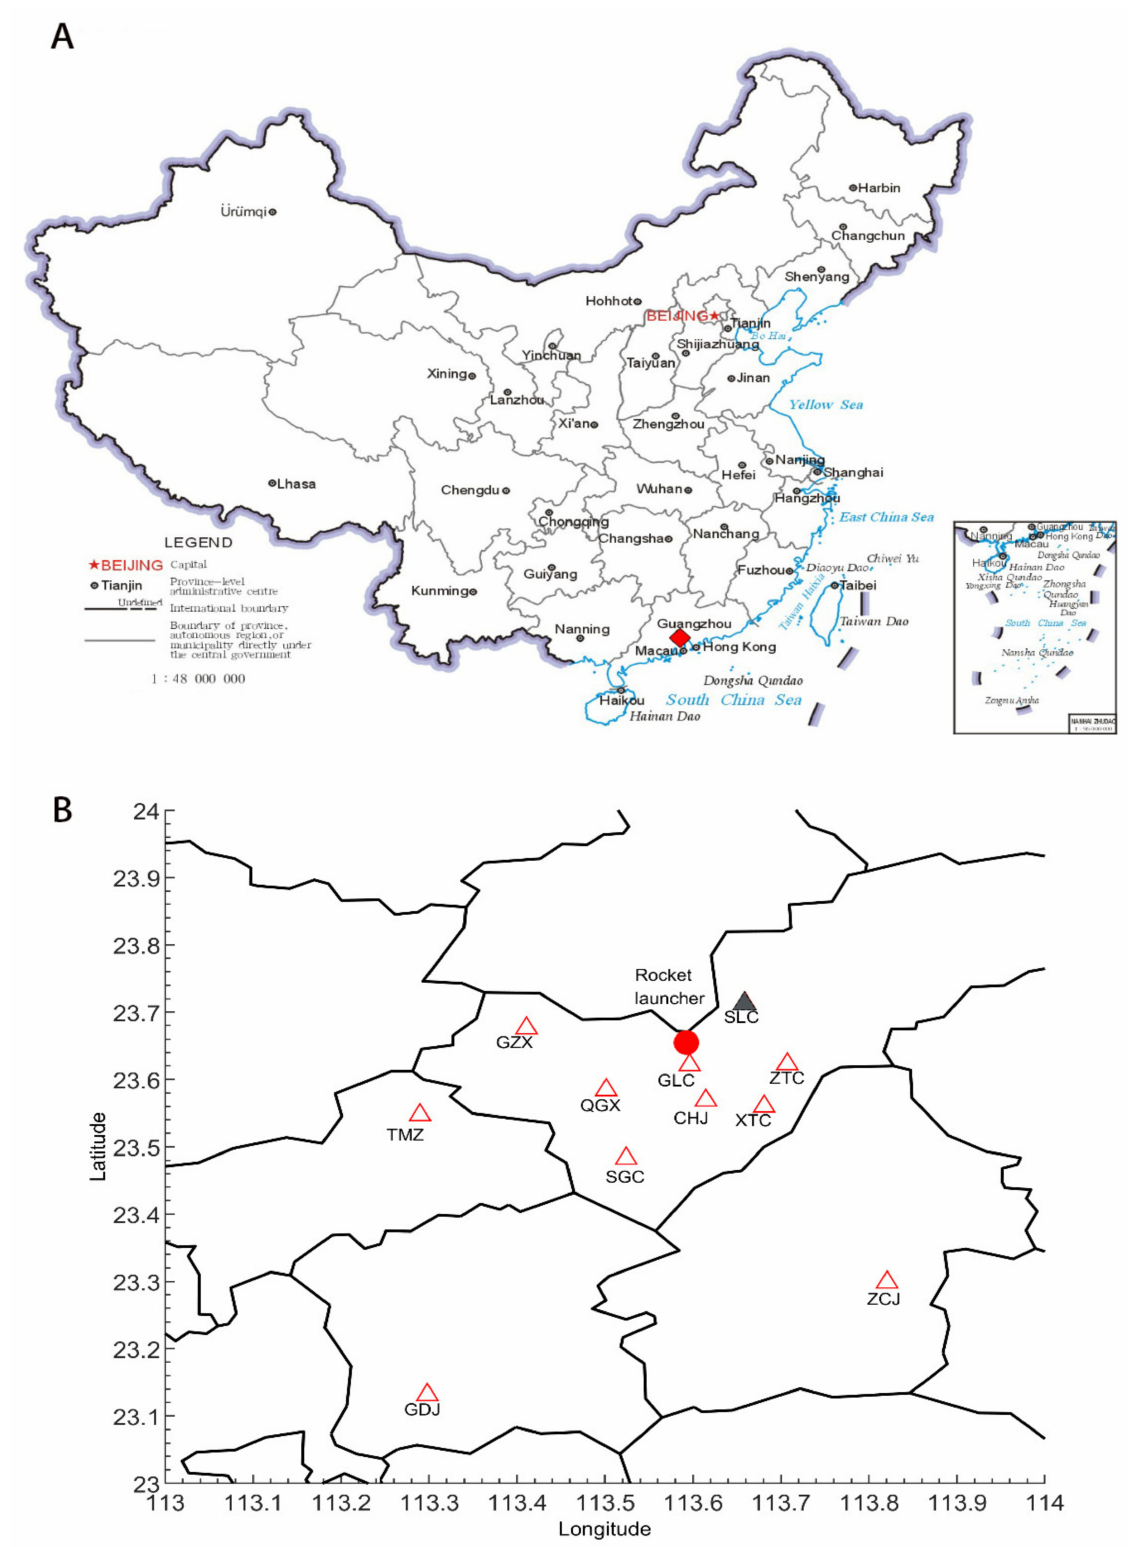
Figure 1. ( A ) The site of LFEDA in the map of China. The red diamond represents the location of LFEDA. ( B ) Geographical layout of low-frequency electric field detection array substations in the Guangzhou area. Stations are represented by triangles, and experiments with artificially triggered lightning are conducted at the position marked by the circle. The SLC station was relocated to the ZTC station in